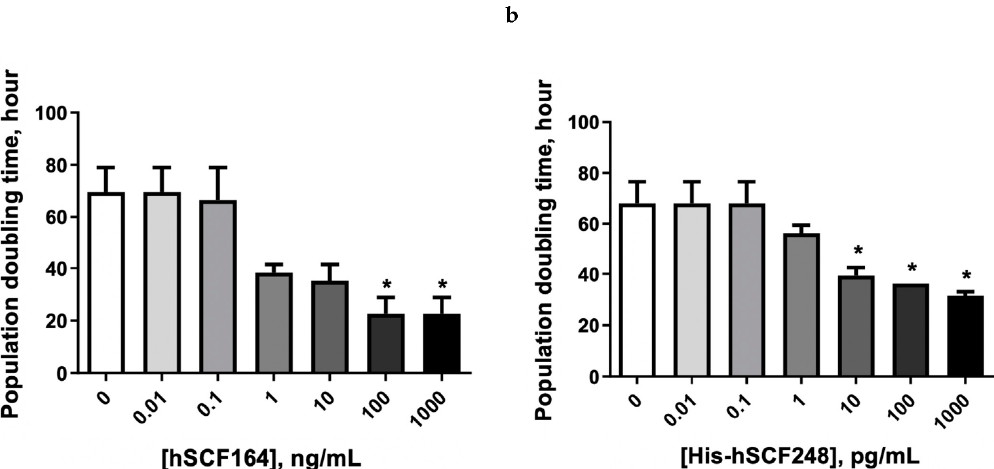
Figure 6. hSCF164 and His-hSCF248 effect on doubling time of TF-1 cells. Dose-dependent cell doubling time (h) was changed by treatment with hSCF164 ( a ) and His-hSCF248 ( b ). Data are presented as the mean ± SEM ( n = 4). One-way ANOVA and Dunnett post hoc test (* p < 0.05).